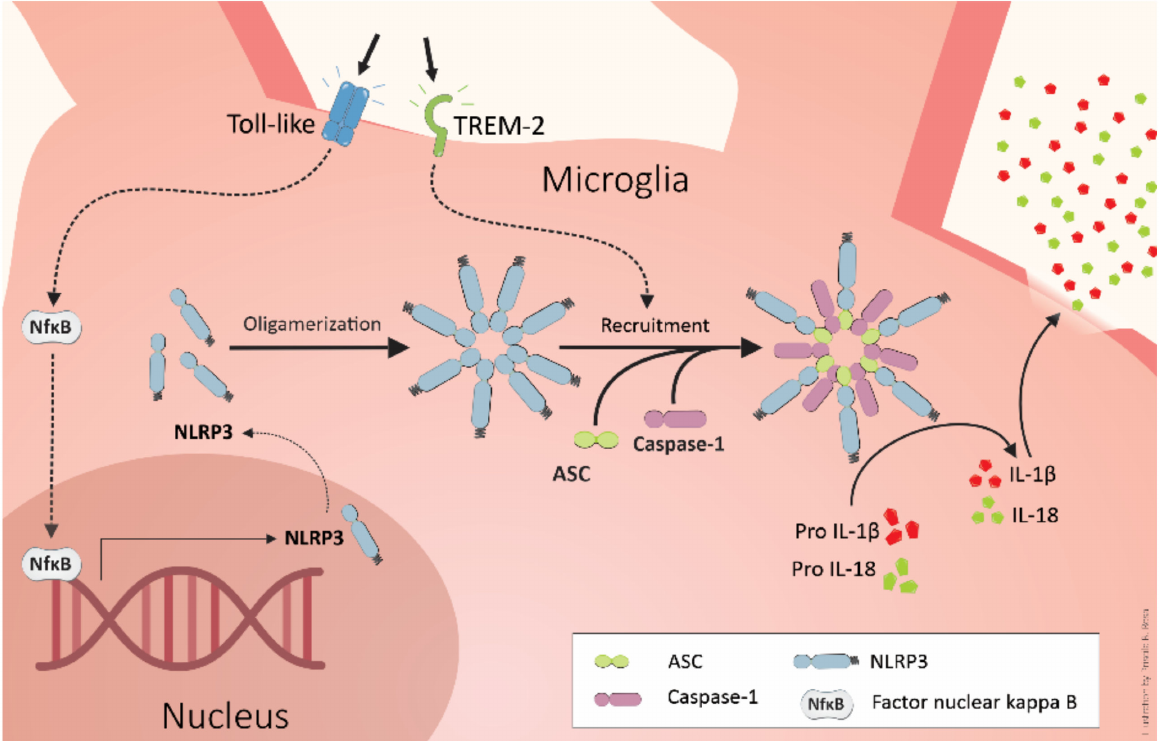
Figure 1. The activation of Toll-like receptors by ligands such as LPS or A β species can trigger the first signal for assembly of the NLRP3 inflammasome through nuclear factor kappa B (NF-kB). The second signal can be triggered after A β -mediated phagocytosis by TREM2. The A β overload causes lysosome disruption, releasing cathepsin B, which induces the signal for assembly of NLRP3. The inflammasome contains caspase-1 that cleaves pro-IL-1 β and pro-IL-18, generating the mature forms of these inflammatory cytokines. IL-1 β and IL-18, in turn, activate neutrophils, macrophages, and other microglial cells, amplifying the inflammatory